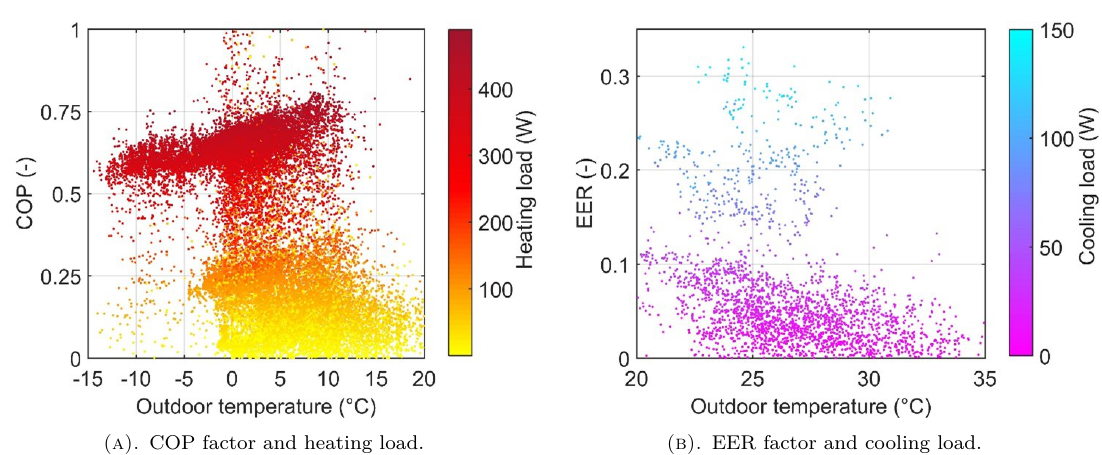
Figure 3. Peltier AC unit efficiency vs outdoor air